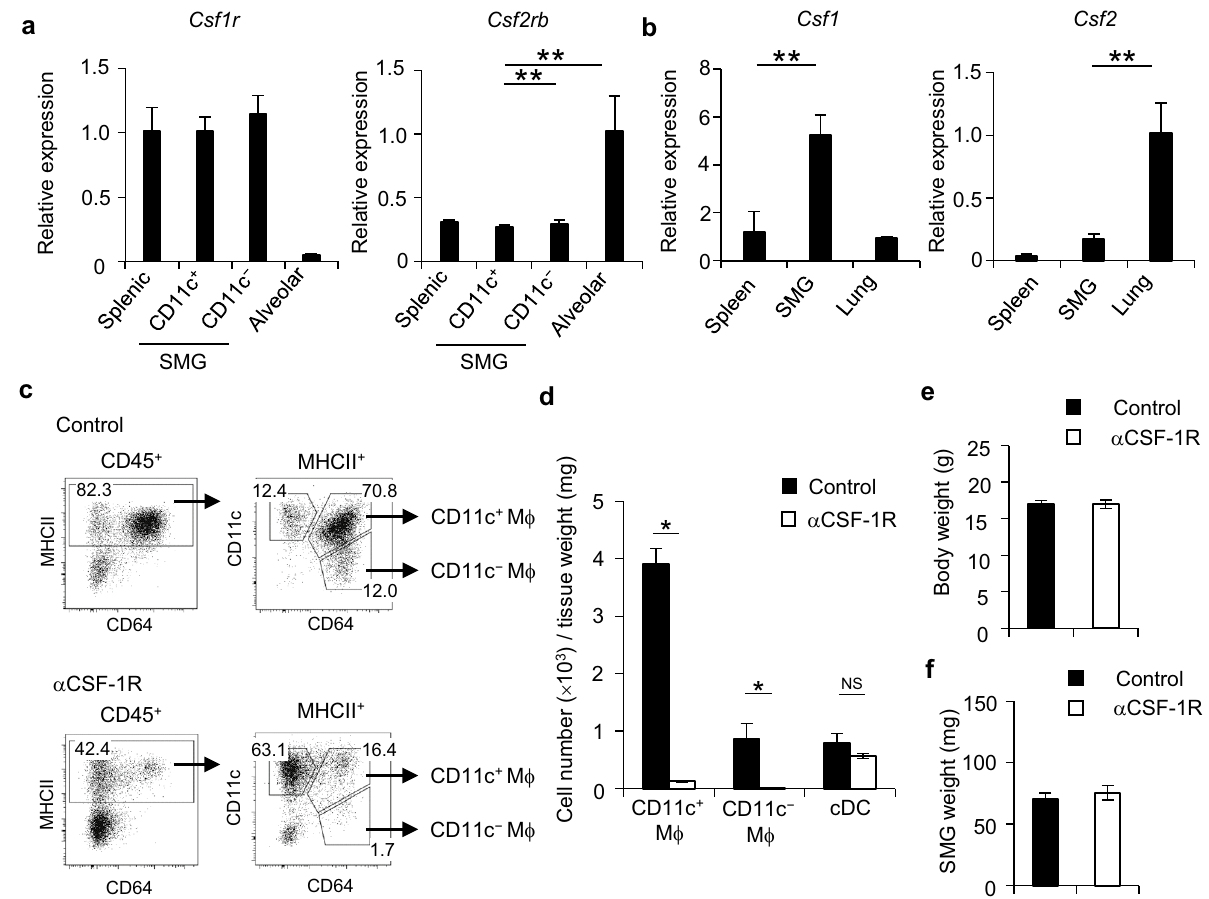
Figure 5. CSF-1 dependency of macrophage subsets in steady-state SMGs. ( a , b ) Female C57BL/6N mice at 8 weeks old were used. The mRNA expression levels of Csf1r and Csf2rb were analyzed by quantitative RT-PCR ( a ). Splenic and alveolar macrophages were the positive controls for Csf1r and Csf2rb , respectively. Expression levels were normalized to β-actin levels and expressed as relative expression based on the value of splenic macrophages ( Csf1r ) or alveolar macrophages ( Csf2rb ). mRNA expression levels of Csf1 and Csf2 in spleen, SMG, and lung tissues ( b ). The spleen and lungs were positive controls for Csf1 and Csf2 , respectively. Expression levels were normalized to β-actin levels and expressed as relative expression based on the value of the spleen ( Csf1 ) or lungs ( Csf2 ). Results are representative of three independent experiments. ( c – f ) Macrophage subsets in steady-state SMGs from control or anti-CSF-1R mAb-injected mice. Female C57BL/6N mice at 7 weeks old were injected with anti-CSF-1R mAb on days 0, 1, and 2, and then analyzed on day 5. Representative FACS plots ( c ), the absolute numbers of CD11c + and CD11c − macrophages ( d ), body weight ( e ), and SMG weight ( f ) in steady-state SMGs from control or anti-CSF-1R-injected mice are shown. Results are representative of two independent experiments. Bars represent the mean ± SD ( n = 3). ** P < 0.01, * P < 0.05 by the Student’s t test with Welch’s correction. Mϕ macrophage, NS not